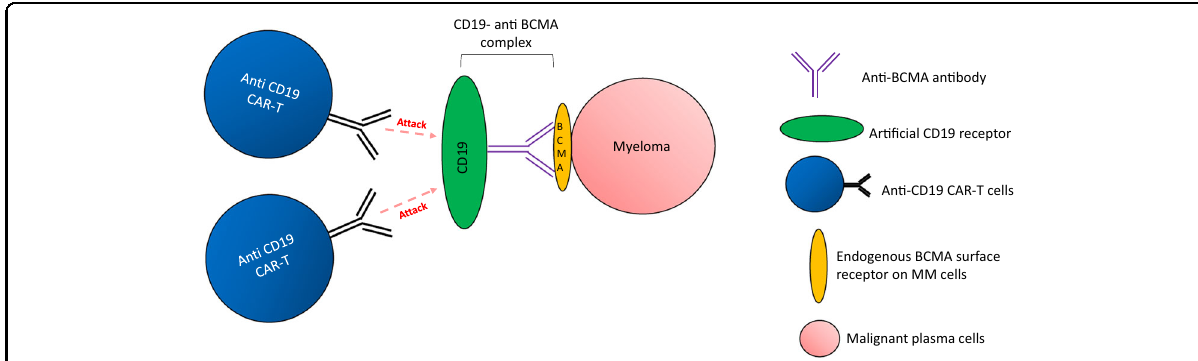
Fig. 5 CD19-antigen decoy for innovative targeting of myeloma cells. Increased expression of CD19 is induced on the myeloma cells by arti fi cially creating the protein-anti-BCMA antibody complex that binds to endogenous surface BCMA. Highly potent and speci fi c anti-CD19 CAR-T can be used to target these synthetic myeloma